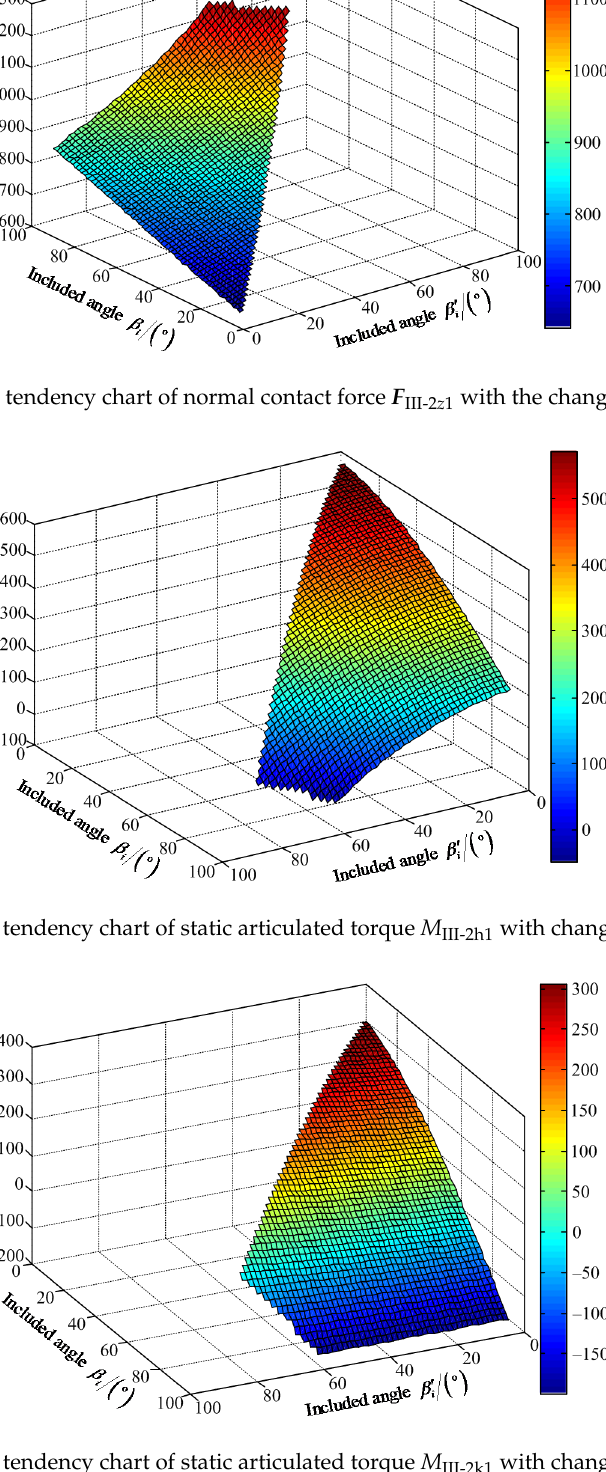
Figure 22. Variable tendency chart of static articulated torque M III ‐ 2k1 with changes of β i ′ and β i .